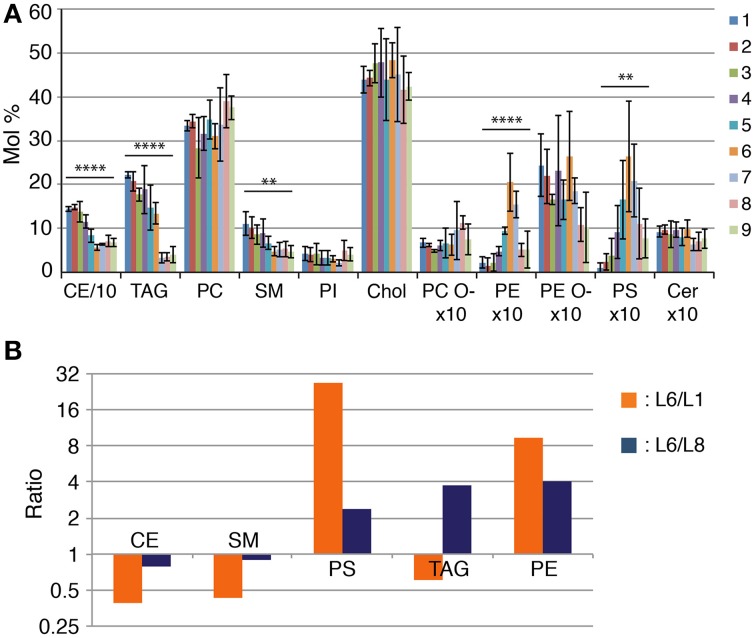
The Lipidome of NE midbodies. (A) Lipid class profile of all sucrose fraction. The content of individual lipid classes was determined by summing up absolute abundances of all identified species and is expressed as mol %. We consider 100% to be all the membrane lipids, meaning that CE and TAG are excluded from the normalization. CE and TAG amounts are also normalized to the total membrane lipids. P-values were estimated by One-Way ANOVA; **P < 0.01, ****P < 0.0001. Error bars correspond to SD (n = 3). CE amounts are divided by 10 and PC O-, PE, PE O-, PS, and Cer are multiplied by 10 for visualization purposes. CE, cholesterol ester; TAG, triacylglycerol; PC, phosphatidylcholine; SM, sphingomyelin; PI, phosphatidylinositol; Chol, Cholesterol; PC O- and PE O-, plasmalogens; PE, phosphatidylethanolamine; PS, phosphatidylserine, Cer, ceramide. (B) Enrichment of lipid constituency in layer 6 (L6) compared to layer 1 (L1) (L6/L1) and layer 8 (L8) (L6/L8), respectively. The y-axis is on a log2 scale.